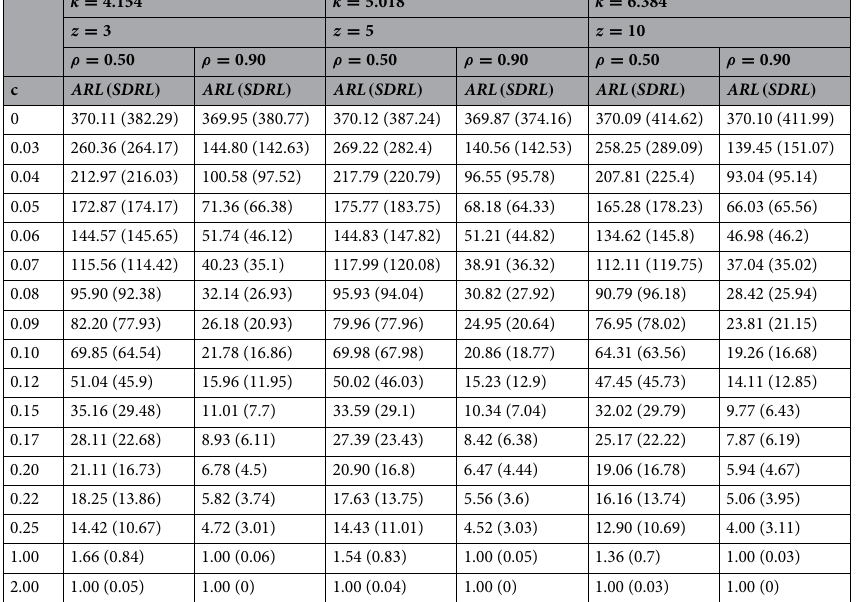
Table 6. ARLs of EEWMA-REMA control chart ARL 0 = 370, n = 5, (cid:31) 1 = 0.1, (cid:31) 2 = 0.03 .